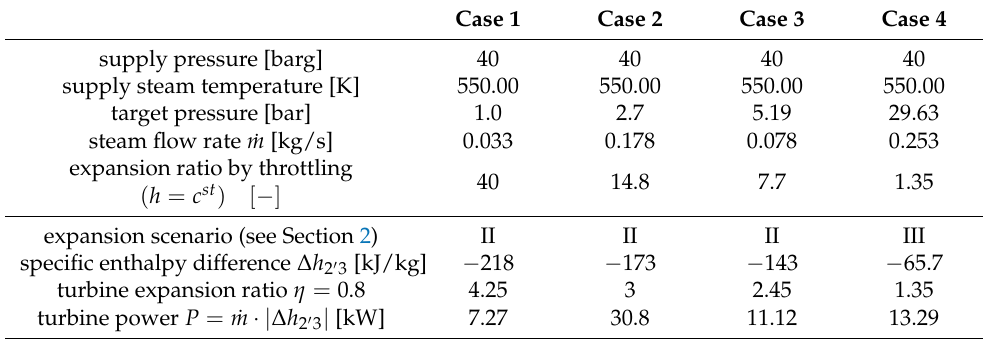
Table 1. Sample of typical steam conditioning cases from